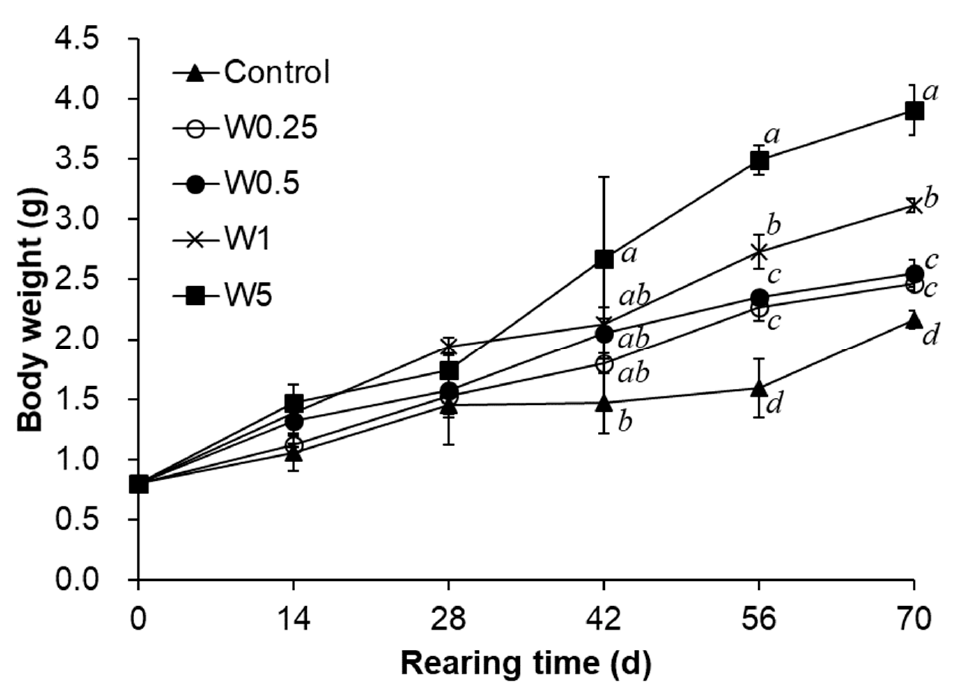
Figure 1. Growth rate of Litopenaeus vannamei reared in the water added with Micro-Aid Liquid 10 once per week at the levels of 0 (control), 0.25 mL m 3 − 1 (W0.25), 0.5 mL m 3 − 1 (W0.5), 1 mL m 3 − 1 (W1) and 5 mL m 3 − 1 (W5), respectively. Data (mean ± SD) with different letters indicate significant differences among treatments ( p < 0.05). n = 3.